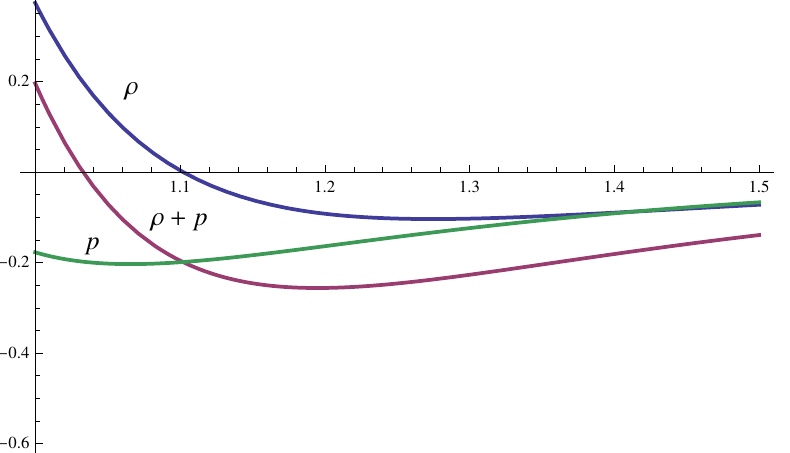
Figure 2. Plot of ρ , p r , and ρ + p r , as functions of the coordinate r , in Planckian units, for ξ = 1 and r 0 =